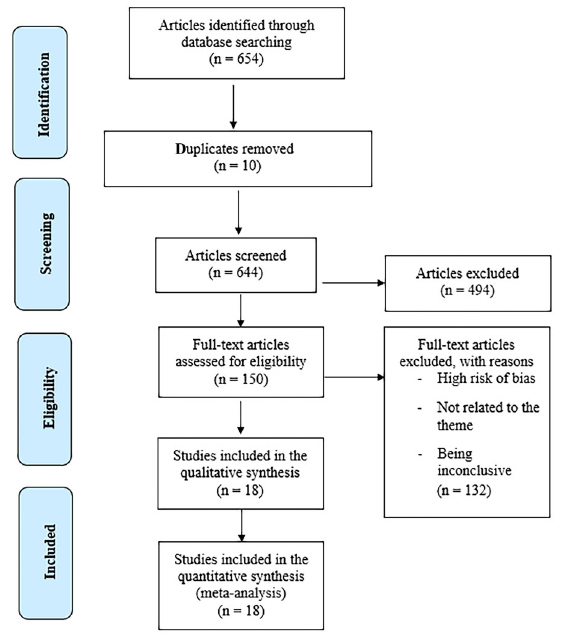
Figure 1. PRISMA fl ow diagram of study